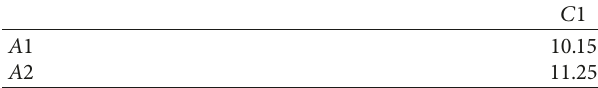
Table 6: Exponential mean cost from S1, S2, and S3 to C1 (in $).